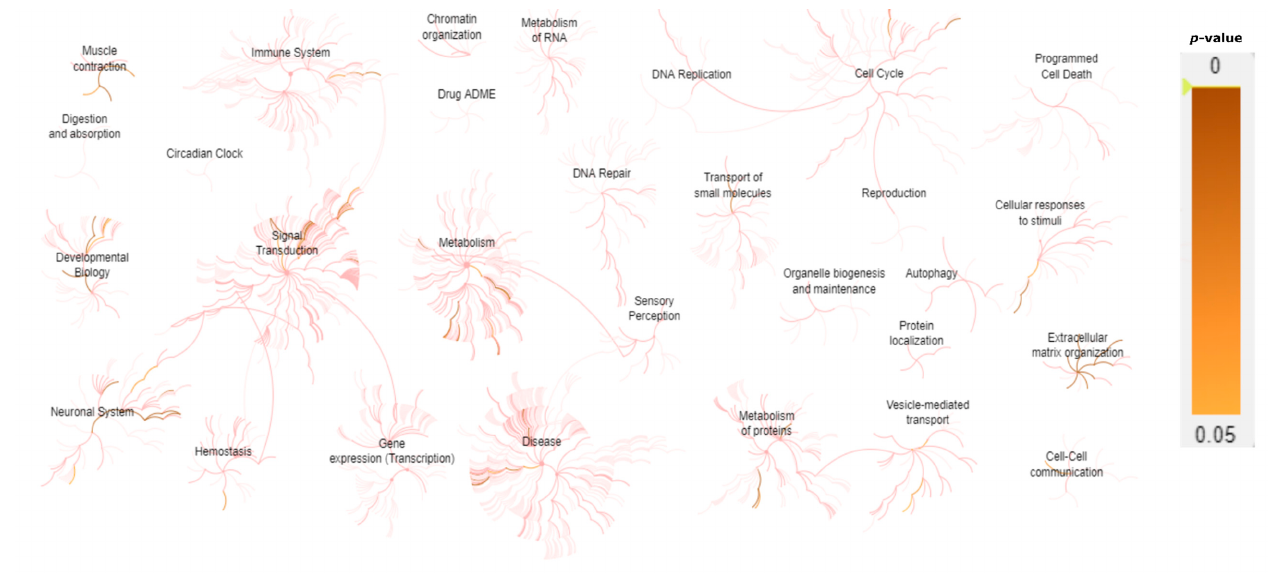
Figure 4. Representation of the predicted biological pathways associated with INMD genes included in the gene-panel design. Gene expression values ( p -value < 0.05) are represented using Reactome pathway enrichment analysis. The majority of the genes included in the INMD gene panel are predicted to be highly expressed in muscle contraction, neuronal system, signal transduction, metabolism, cell cycle, ECM, vesicle-mediated transport, and cellular responses to stimuli. Table 1. Representation of the predicted biological systems affected due to pathogenic variants in the associated genes, leading to the development of INMD, using the Reactome pathway